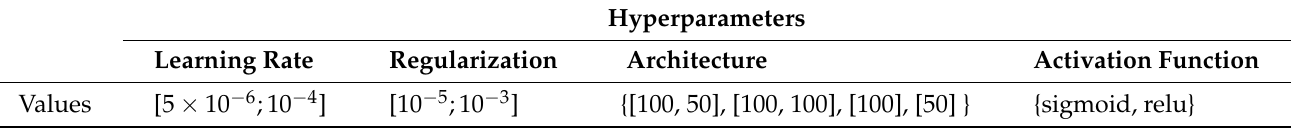
Table 4. The list of hyperparameters considered in our search strategy. The learning rate is the stochastic gradient descent initial learning rate and is included as a [min; max] range; the same notation is used for the regularization parameter, noted as λ in Sections 3.2.1–3.2.3. Our strategy could also employ one of the four reported architectures in their hidden layers. Lastly, sigmoid and rectified linear units were considered as the activation functions for each hidden layer.